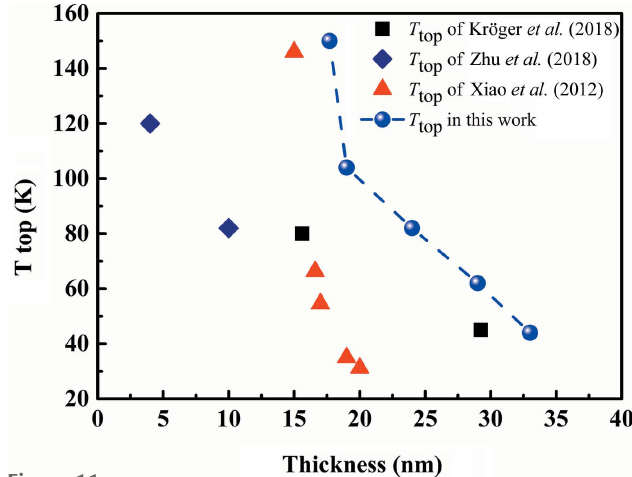
Figure 11 Comparison of T top in single-crystal and polycrystalline Bi thin films. The variation of T top of Bi thin films with different thicknesses. The squares represent the T top of Bi(111) film grown on Si(111) in the work by Kro¨ger et al. (2018), the rhombuses represent the T top of Bi(111) film grown on Si(111) in the work by Zhu et al. (2018), the triangles represent Bi(111) film grown on BaF 2 (111) in the work by Xiao et al. (2012) and the dots represent Bi(00 l ) film grown on glass in this work.